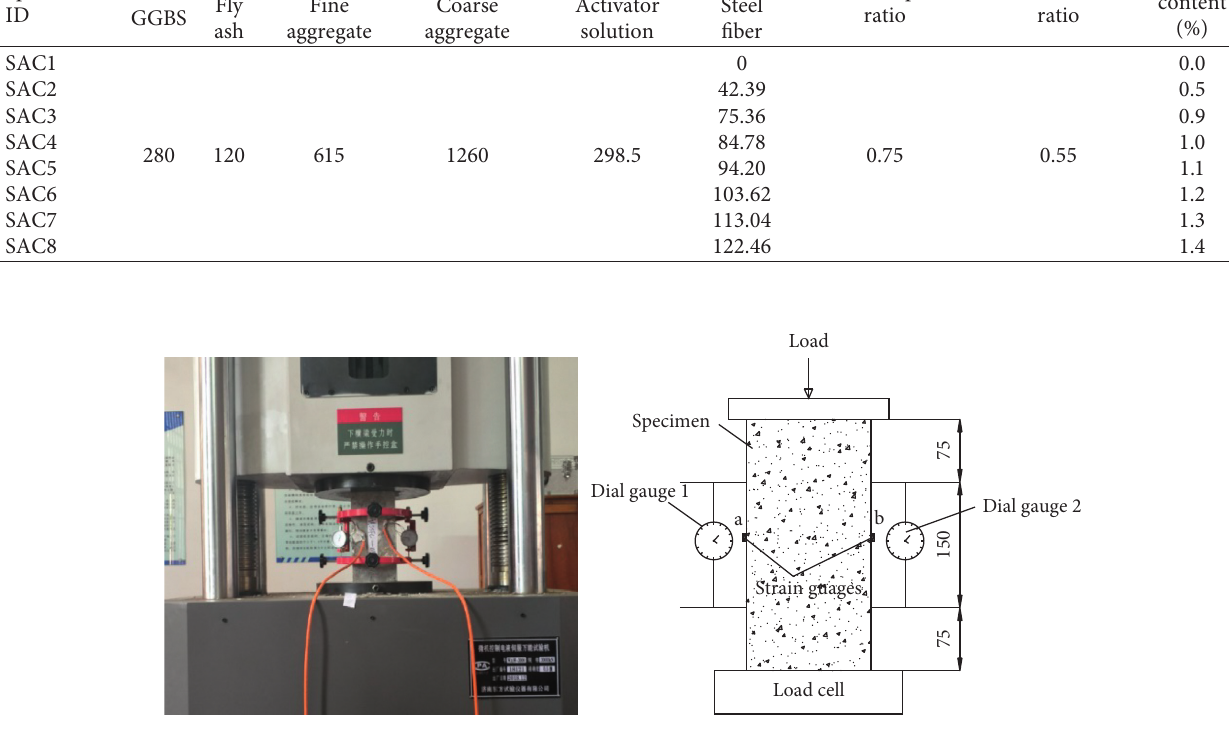
Figure 2: Experiment setup test.